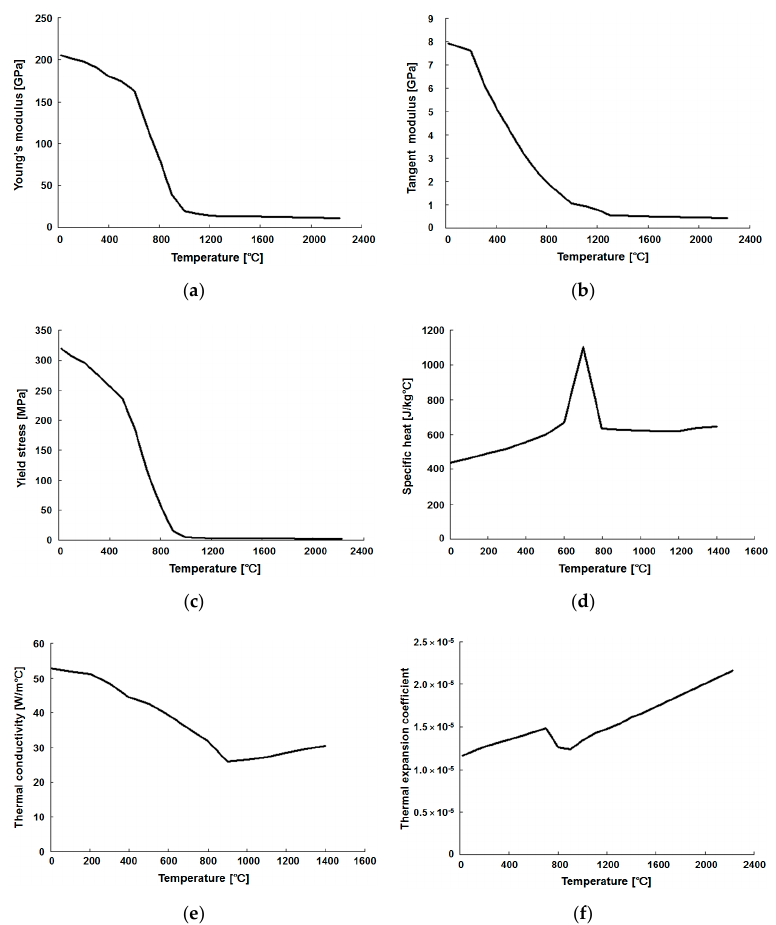
Figure 9. Temperature-dependent material properties: ( a ) Young’s modulus; ( b ) tangent modulus; ( c ) yield stress; ( d ) specific heat; ( e ) conductivity; and ( f ) thermal expansion coefficient. Table 4. Agreement test for experimental and analysis results (specimen 1).